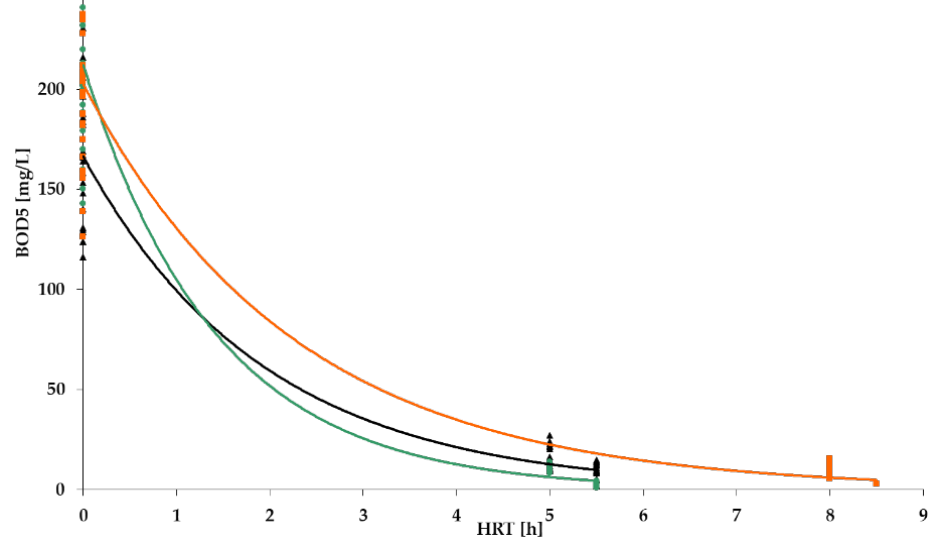
Figure 18. BOD 5 removal dynamics: stage 1 (black); stage 2 (green); stage 3 (orange).